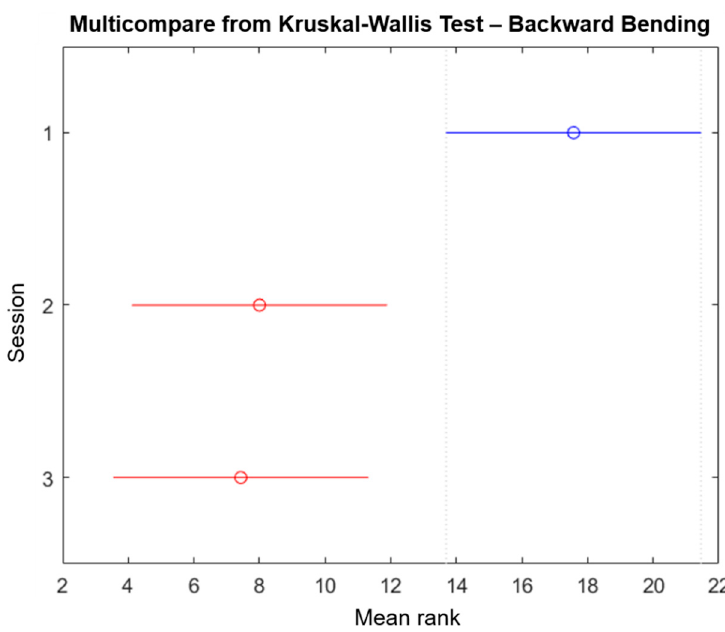
Figure 10. “Multicompare” from the Kruskal–Wallis test for backward bending, where sessions 2 and 3 are significantly different from session 1.